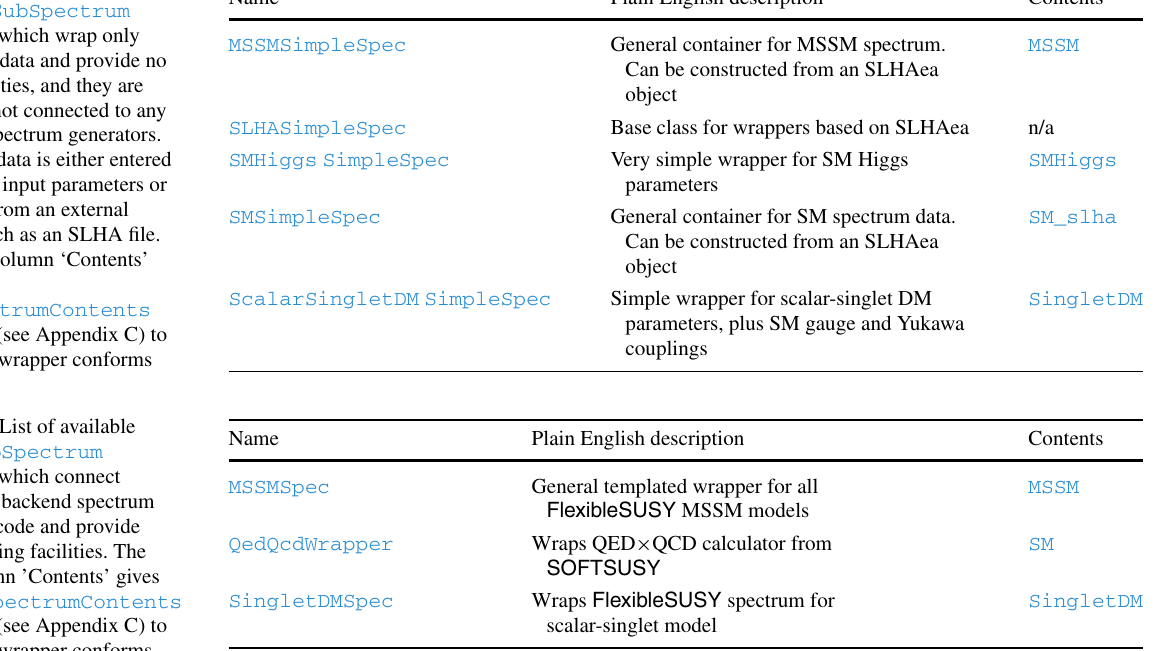
values for those indices using the listed “Helper class”; see text. In the table, the name Self refers to the SubSpectrum wrapper class itself (that is, these maps accept function pointers to members functions of the wrapper